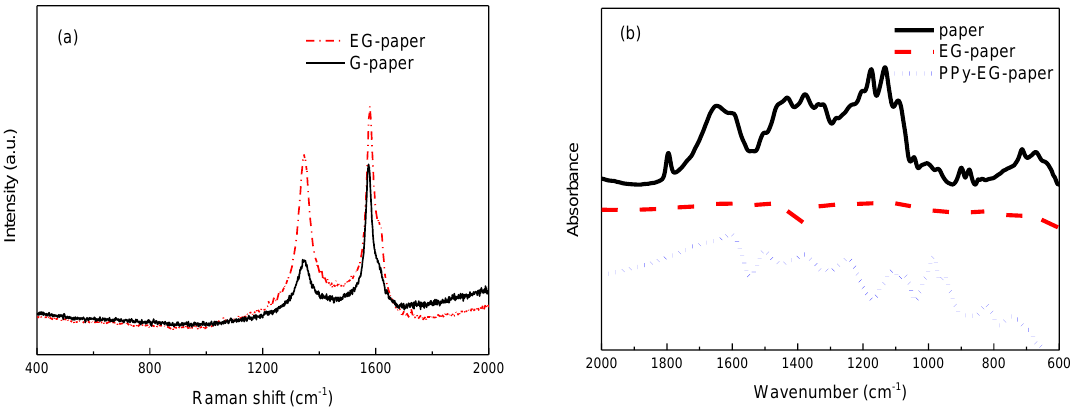
Figure 4. ( a ) Raman spectra of G-paper and EG-paper; and ( b ) FTIR spectra of the blank paper, EG-paper, PPy-EG-paper.